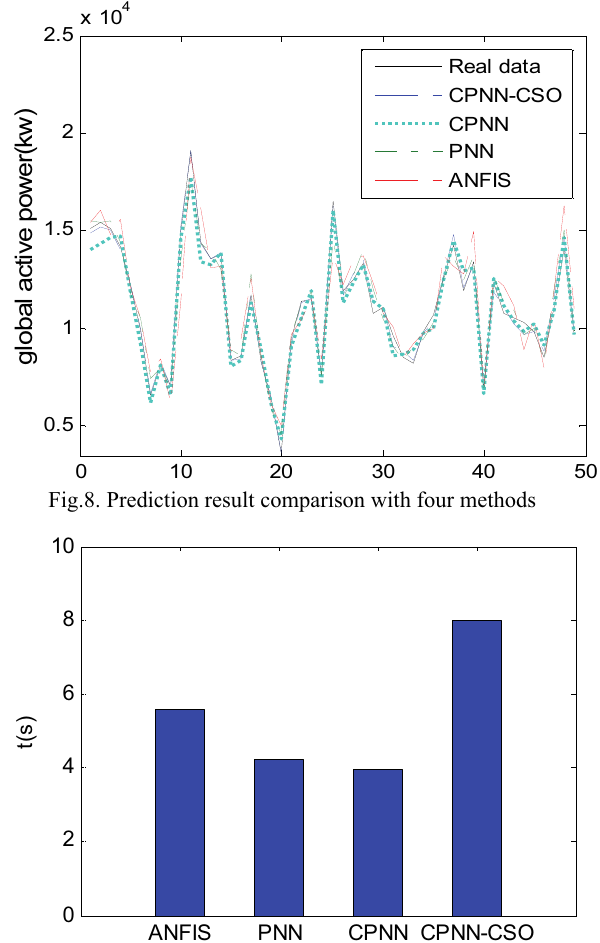
Fig.9. Average elapsed time comparison with four algorithms Comparison is done with four methods on average